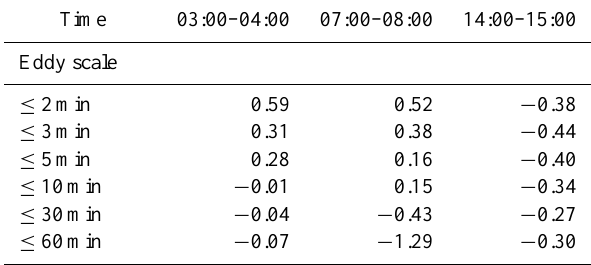
Table 1. Local stability parameter ( z − d)/L c of the eddies in dif- ferent temporal scales on 25